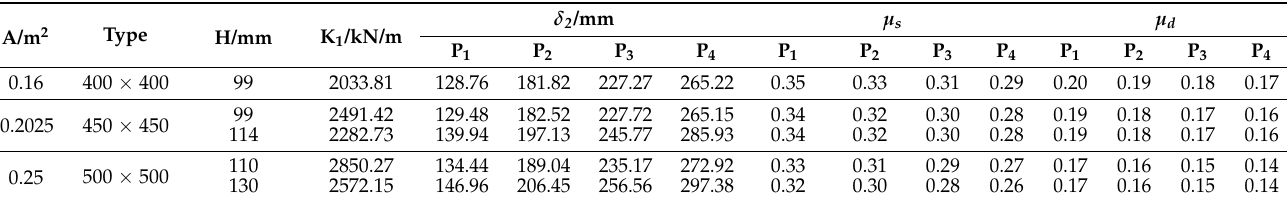
Table 4. LRB constitutive model at concrete surface.